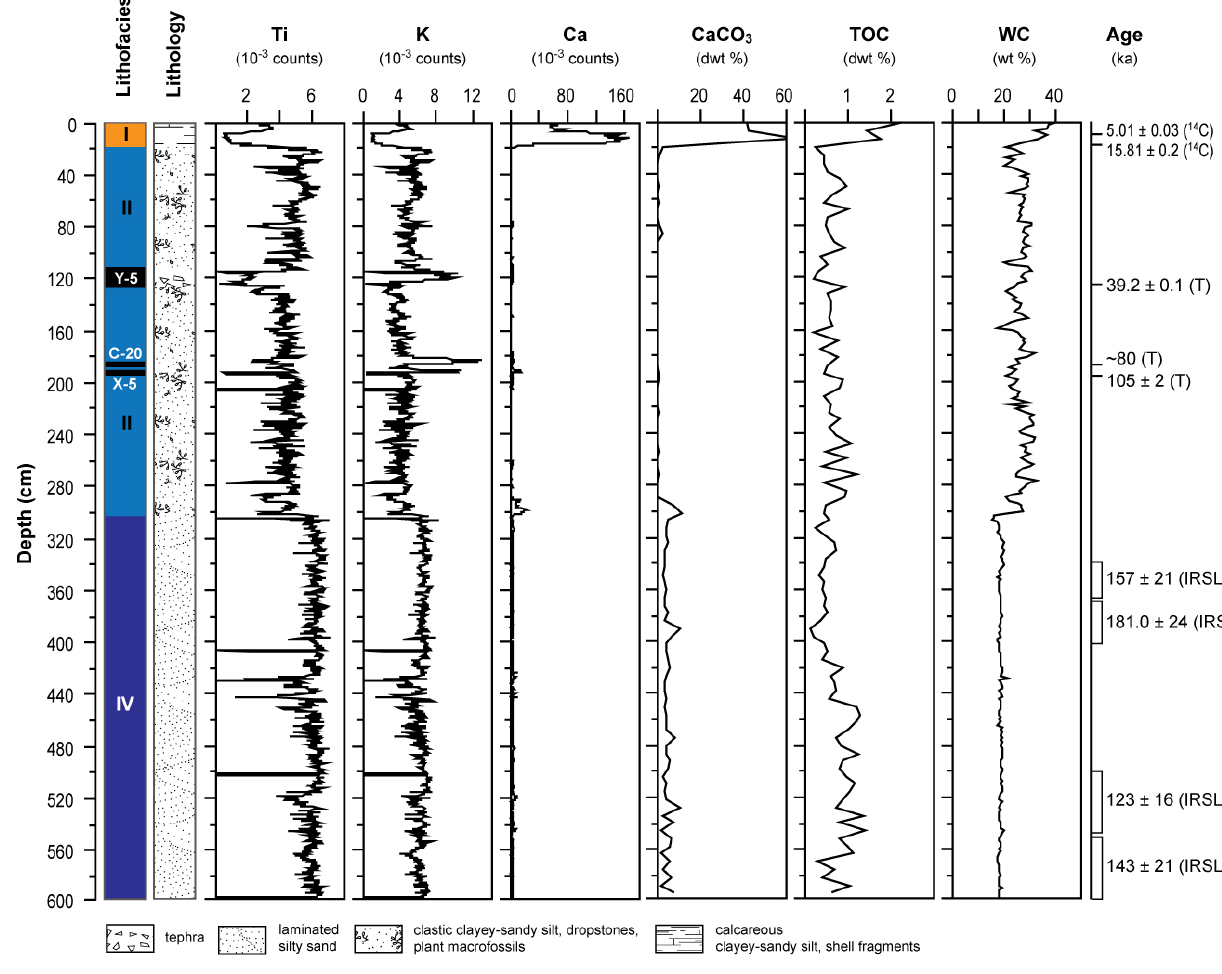
, total organic carbon (TOC) dry 3 3